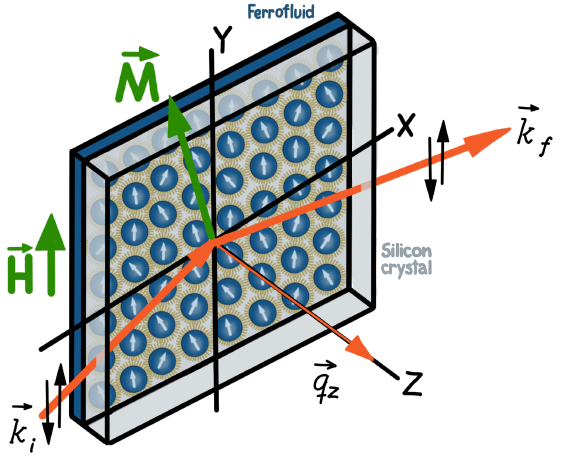
Figure 1. Schematic of the polarized neutron reflectivity measurement configuration that depicts the nanoparticles in the sample cell, along with the spin directions of the incident and scattered neutron beams ( k i , k f ). The wave vector q z denotes the momentum transfer perpendicular to the sample